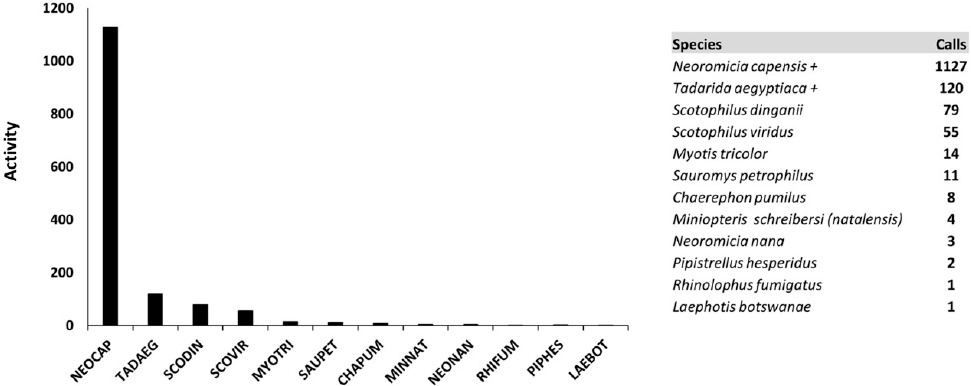
Figure 6. Distribution of activity levels for the 12 bat species identified in Kgalagadi Transfrontier Park in 2016. Species abbreviations in figure represent the first three letters of the generic and specific names and correlate with the list provided + indicates highest detection rates.